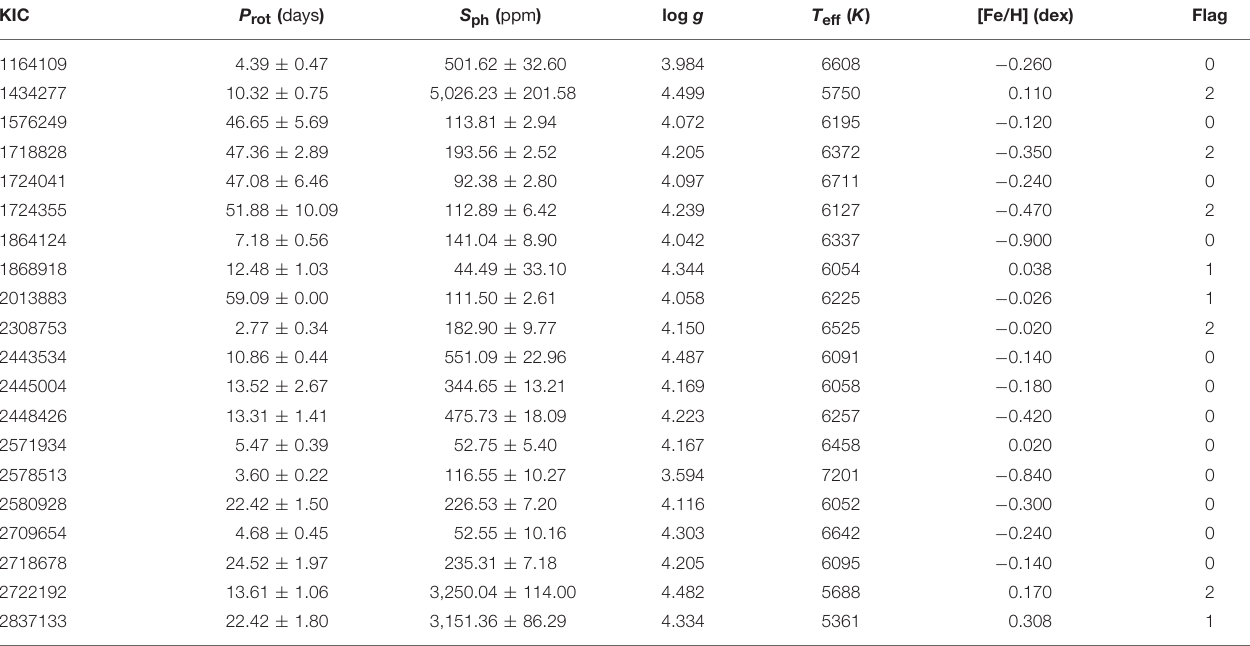
TABLE 1 | Non-oscillating stars with reliable rotation periods measured in this work (The full table is available in the Supplementary Material ). KIC P rot ( days ) S ph ( ppm ) log g T eff ( K ) [Fe/H] (dex) Flag 1164109